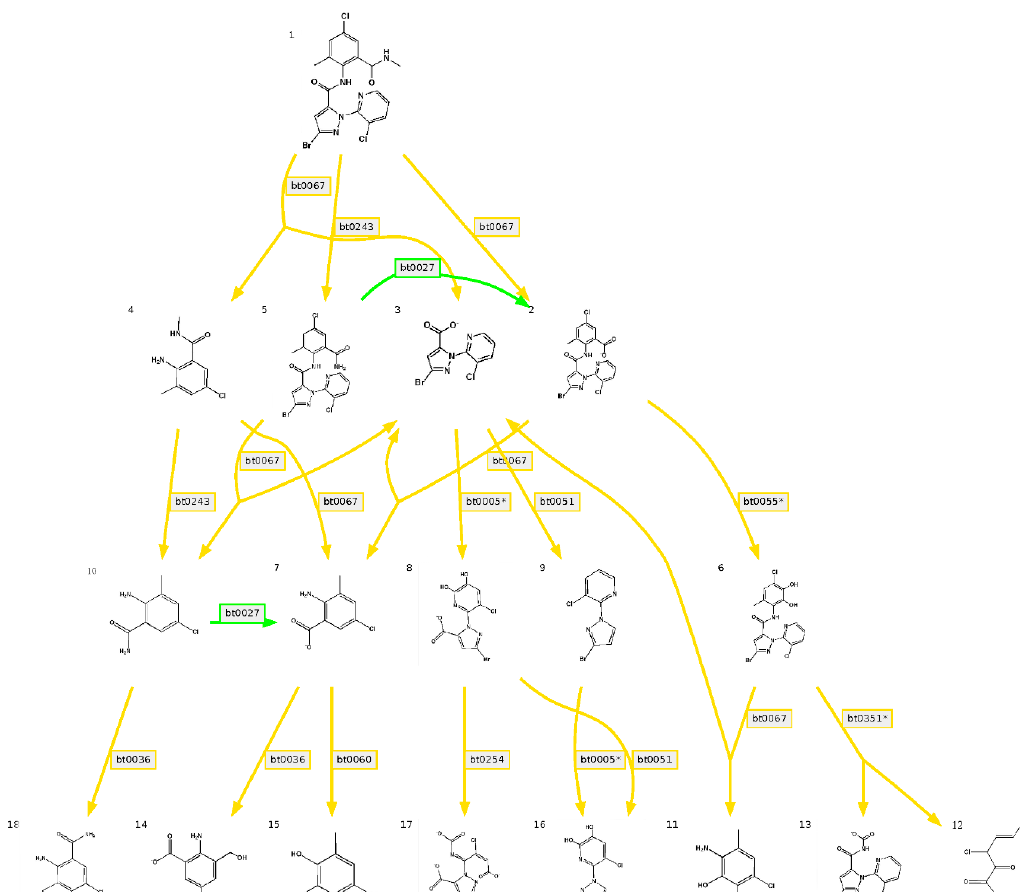
Figure 8. Kyoto Encyclopedia of Genes and Genomes (KEGG) database metabolic pathway classification map of GW13 genome.